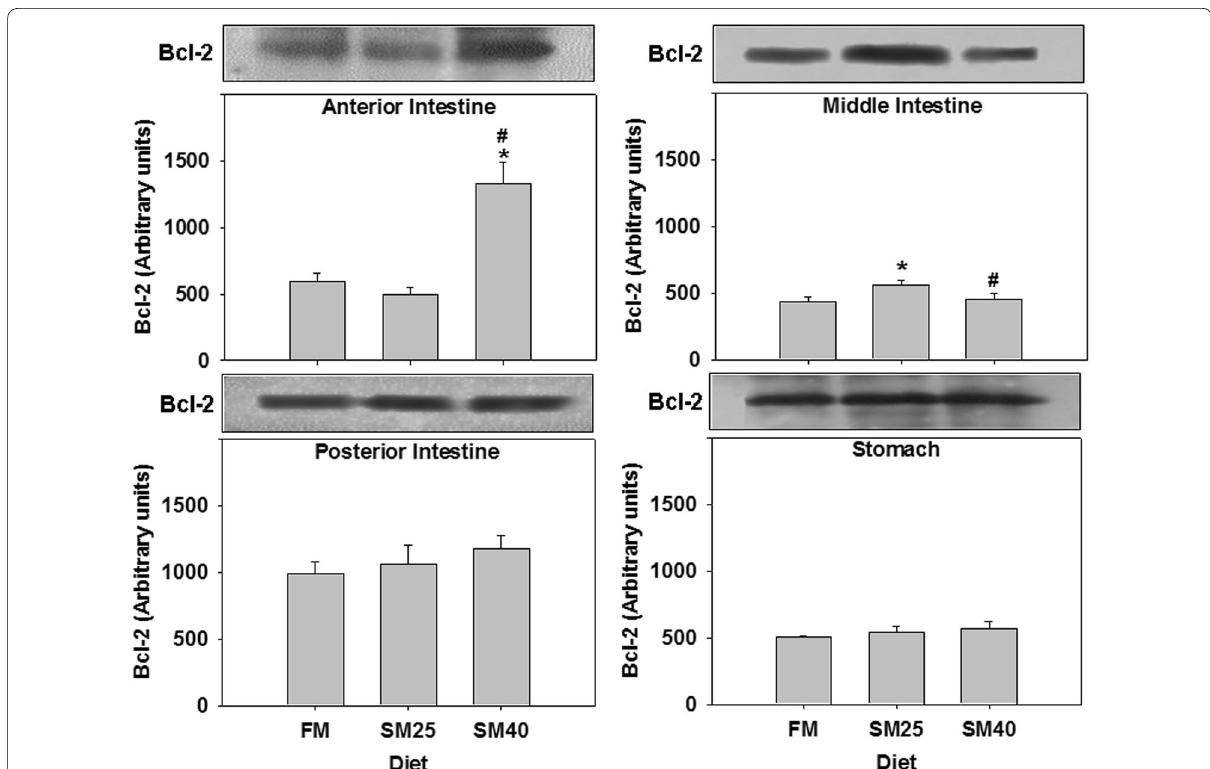
Fig. 3 Bcl-2 levels in the anterior, middle, posterior intestine and stomach of common dentex ( D. dentex ) under the FM, SM25 and SM40 diet treat- ment. Representative protein bands are shown on the top of the panel. Western blots are representative of at least three independent experiments with overlapping results and data represent mean SD for at least three independent experiments; n 8 preparations from different animals. ± = * p < 0.05 compared to FM; # p < 0.05 compared to